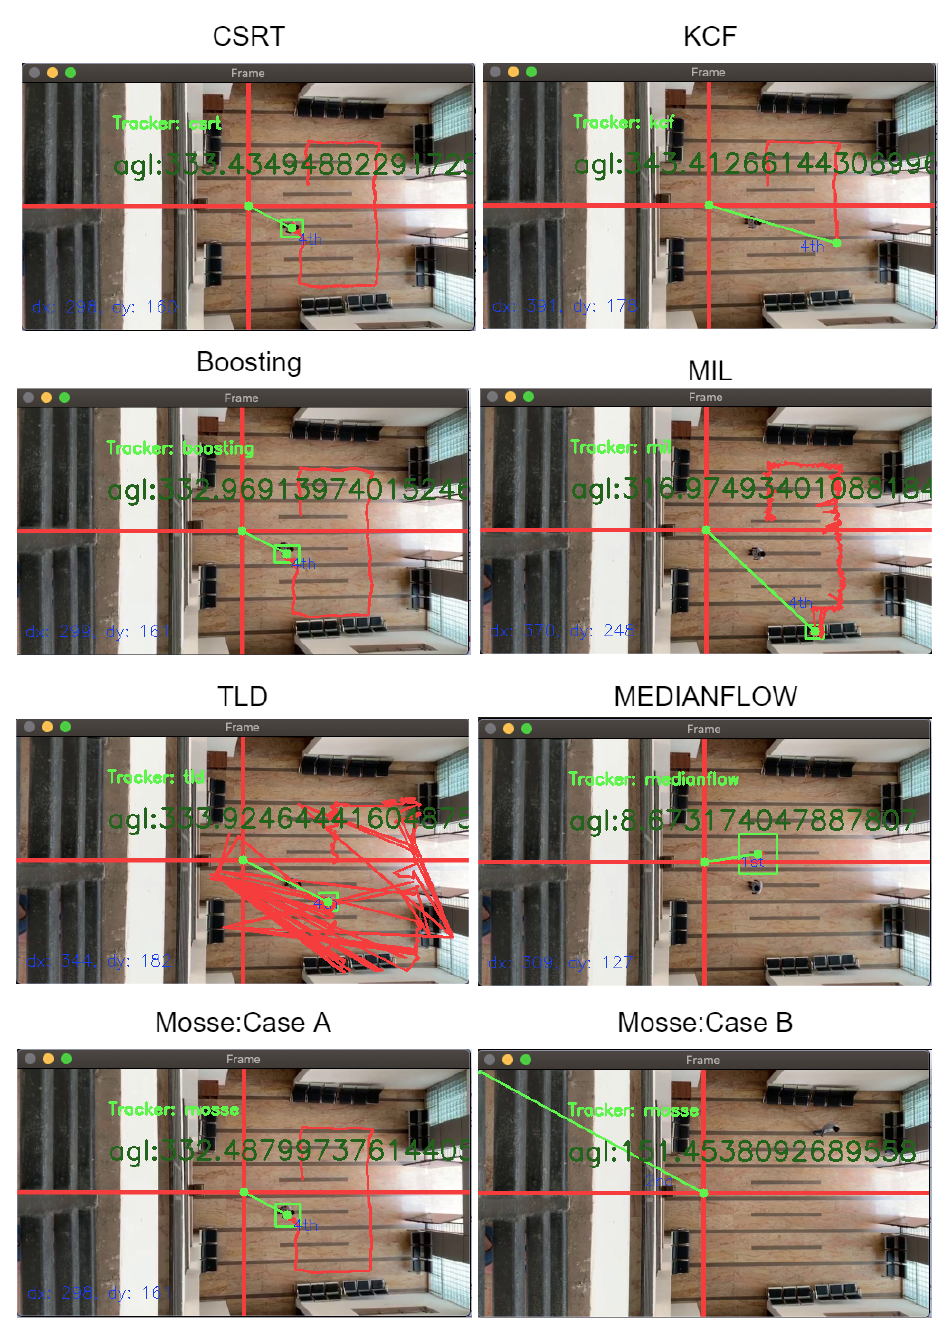
Figure 18. Comparison of tracking